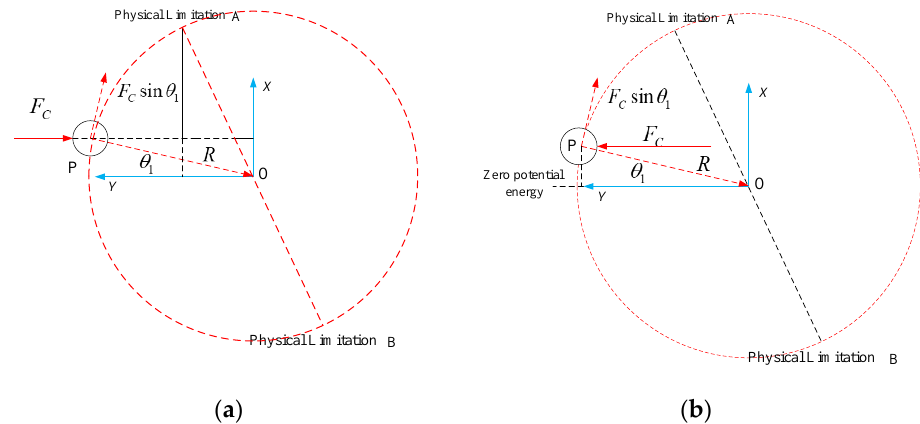
Figure 5. The force model of shaft. ( a ) The force towards center; ( b ) The force backwards center. The kinematic model of the rotation shaft is: